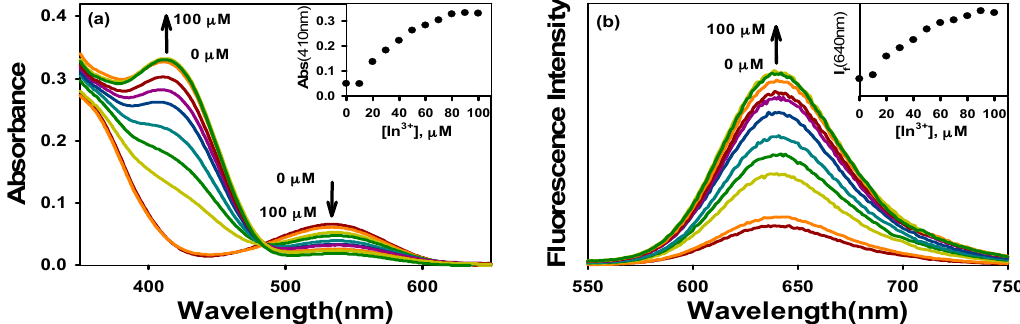
Figure 11. ( a ) Absorption and ( b ) fluorescence spectra of SP-IQ after placed in the dark for 7 h with the addition of In 3+ (0–100 μ M, Different color lines represent different In 3+ concentrations.). Inset: Plots of ( a ) absorbance at 410 nm and ( b ) fluorescence intensity at 640 nm vs . [In 3+ ].